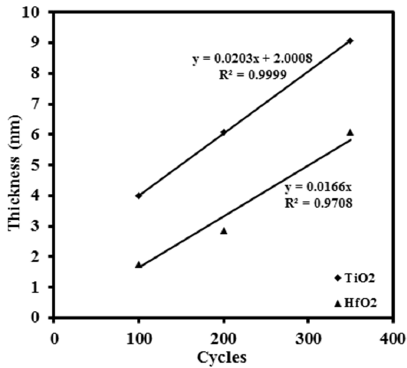
Figure 11. The thin film thickness versus ALD cycles for titanium oxide and hafnium oxide, respectively. The slopes of the two fitting straight lines ( y = 0.0203 x + 2.0008 and y = 0.0166 x )